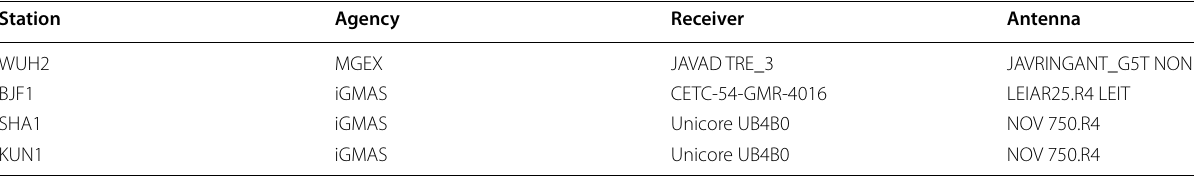
Table 3 Basic information of stations Station